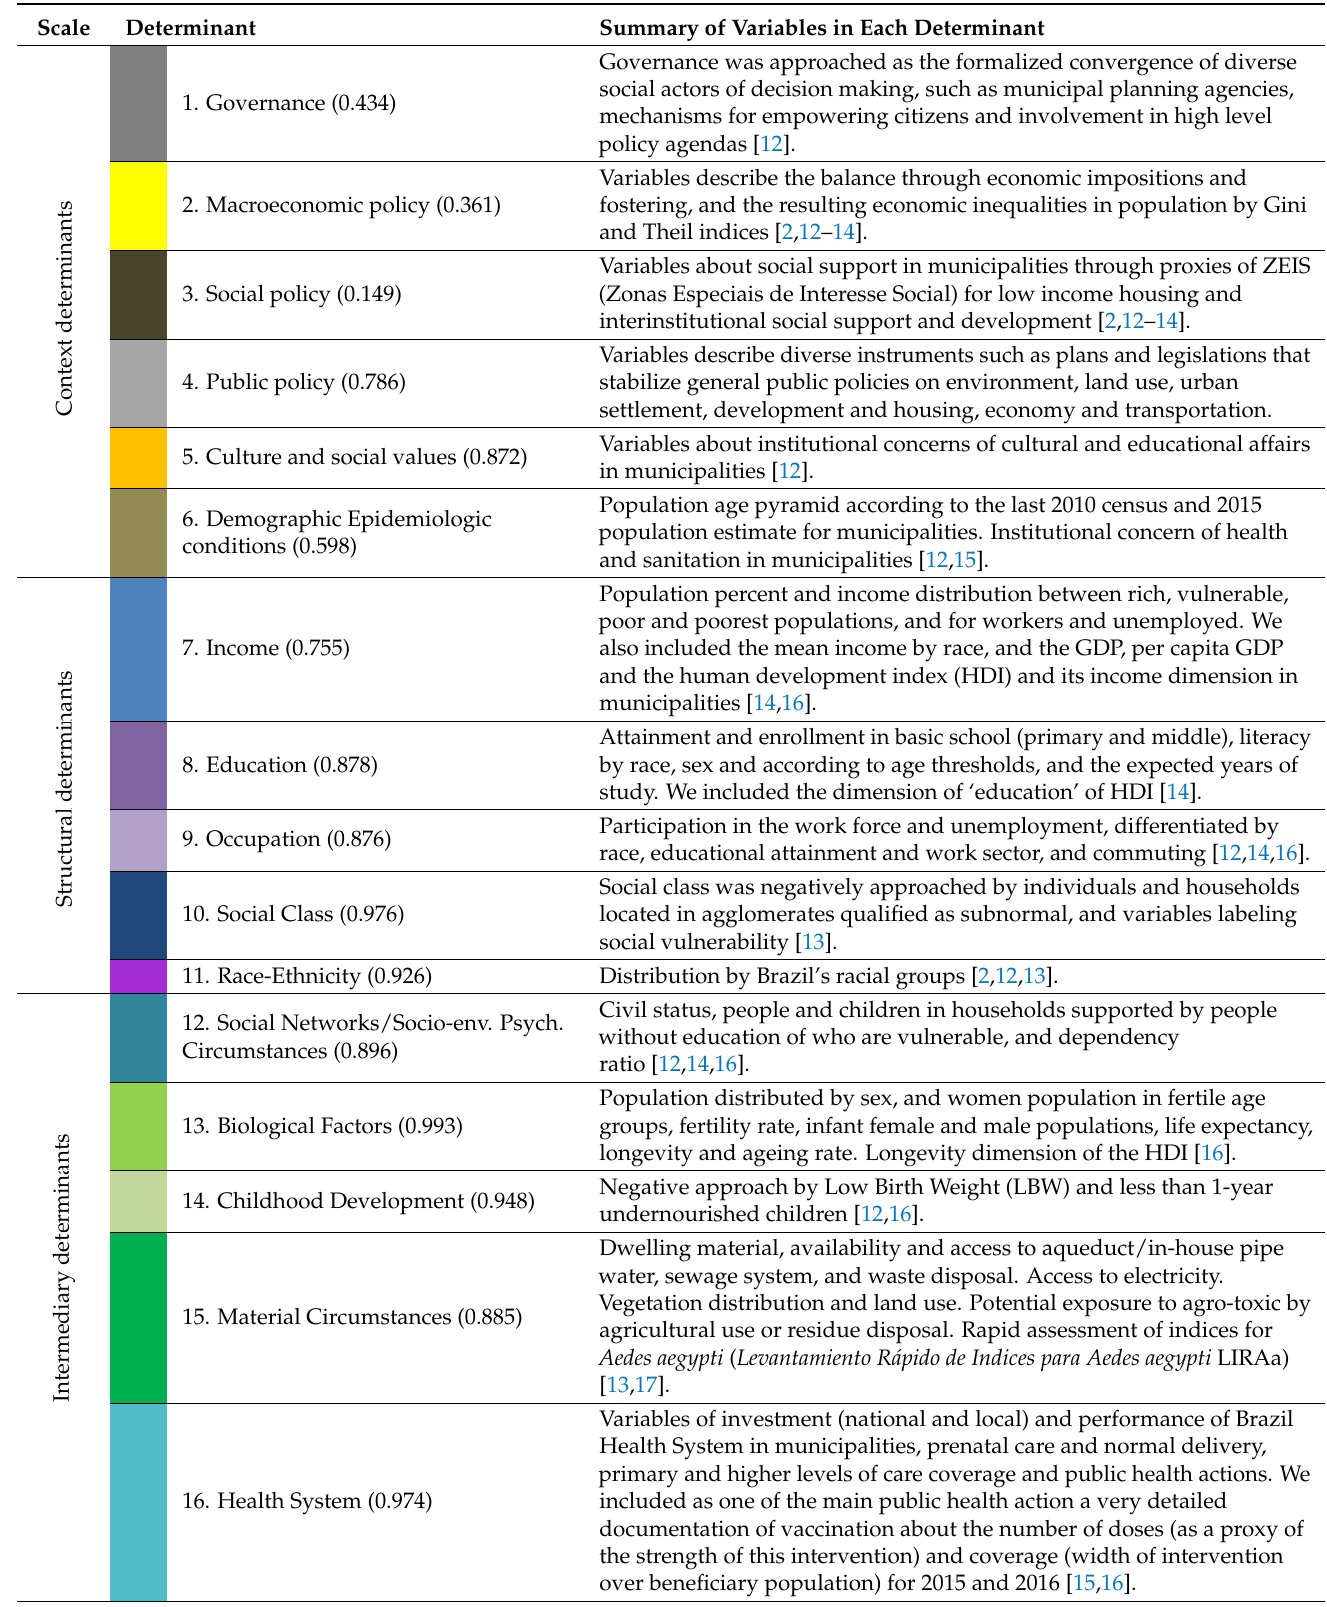
Table 1. Determinants of health and health outcomes related to microcephaly attributed. to ZVI included in the model. For each determinant (arrows = Context, Structural, Intermediary, and Health) are included the Cronbach alpha values. [0.70 and above is good, 0.80 and above is better, and 0.90 and above is